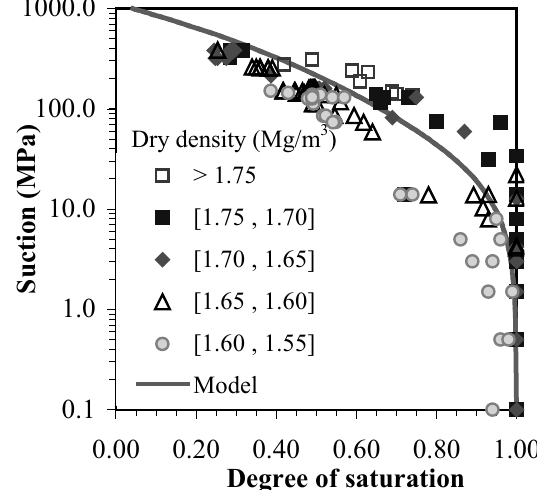
Fig. 5 – Thermal conductivity: FEBEX bentonite experimental results (symbols) and model